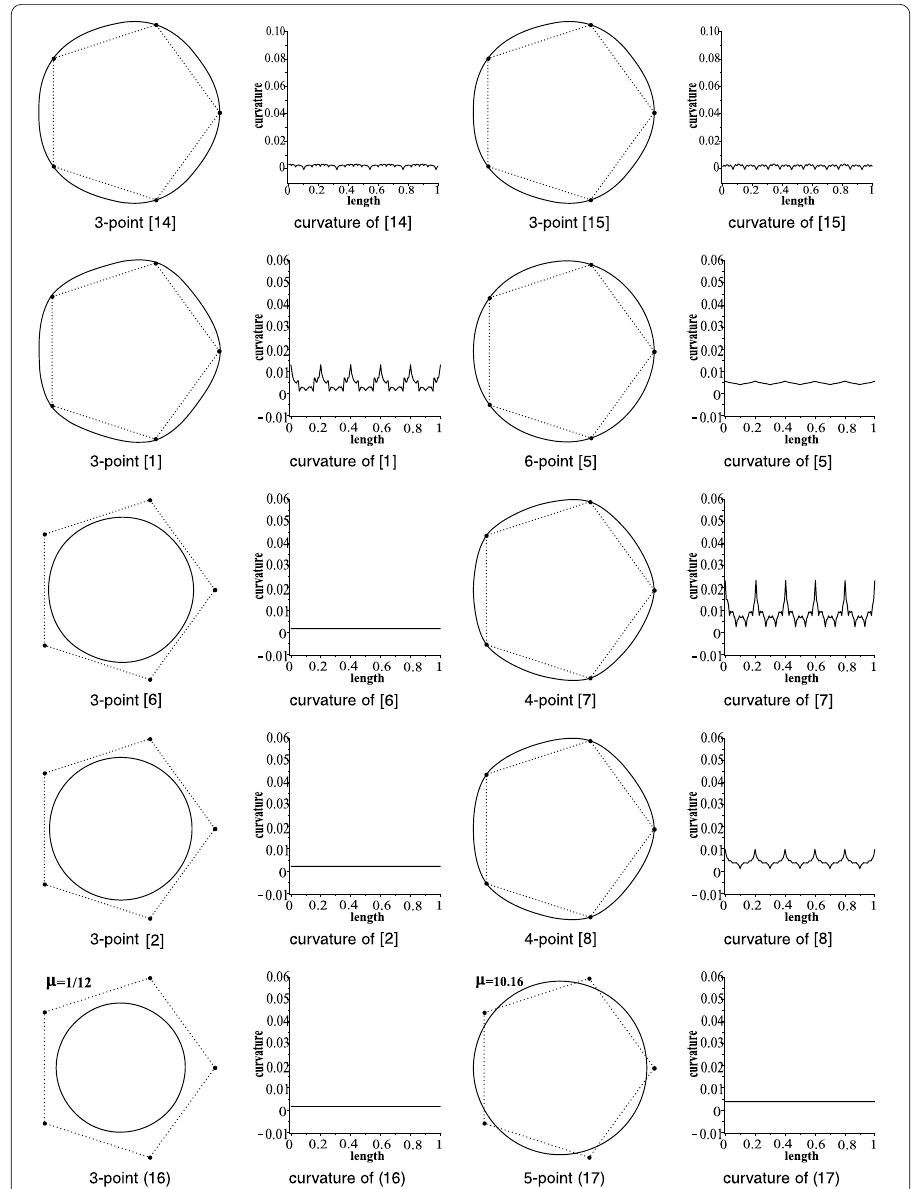
Figure 6 Comparison of existing and proposed SS when five control points are sampled from circle. Left: Limit curves obtained after the 5th iteration, the corresponding curvature is shown in the right column,